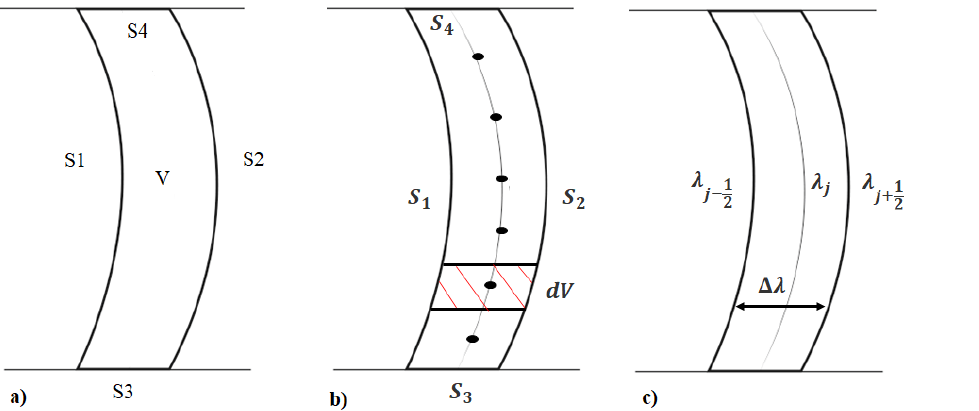
Figure 4. ( a ) Volume element for the FVM approach to solve the electron energy equation; ( b ) nodes on a magnetic streamline and example of an associated volume ( dV ) used in the integration of A i factors; ( c ) integration surfaces of a fluid